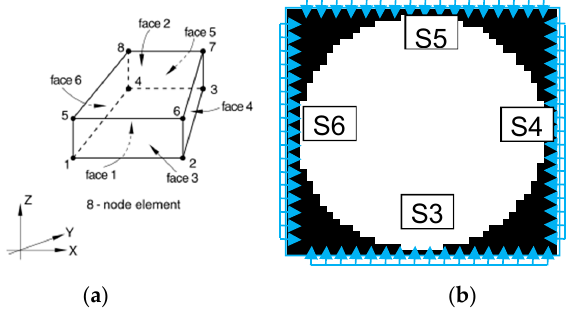
Figure 7. ( a ) Definition of node and surface order for three-dimensional solid element; ( b ) schematic diagram of the confining pressure of the cross section.